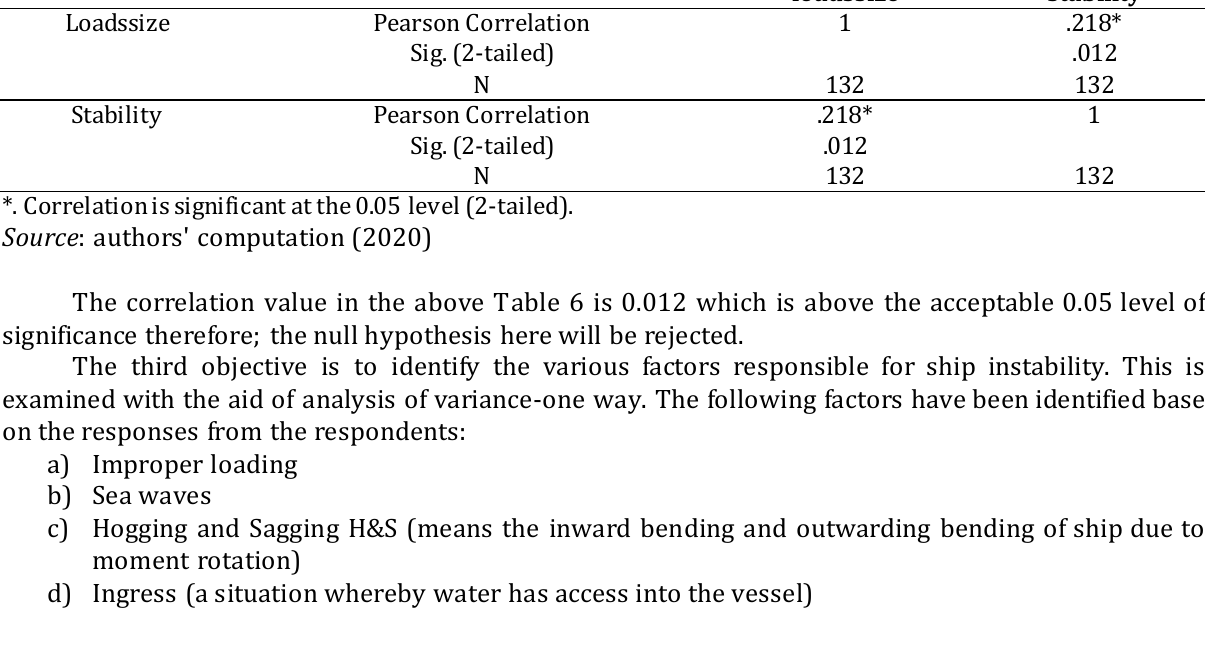
loadssize stability